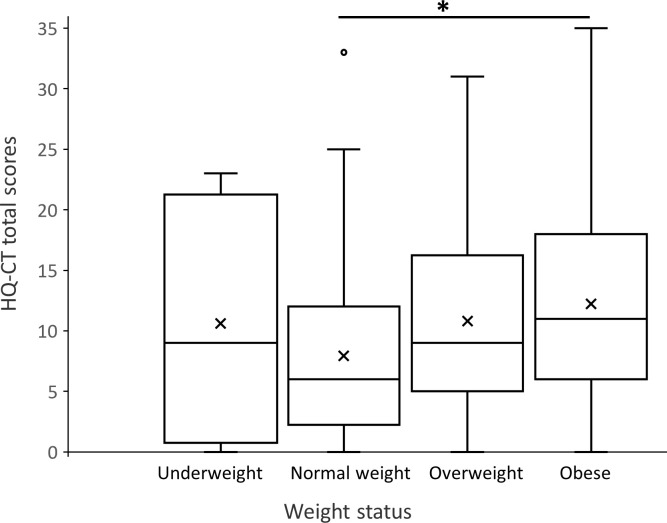
Relationship between weight status and hyperphagia.Box-and-whisker plots showed the range of HQ-CT total scores in function of individual’s weight status (*p < 0.05). Within the boxplot, the mean value is represented by the black cross, the median by the horizontal dividing line, and the top and bottom of the box represent the seventy-fifth and twenty-fifth percentile, with the whiskers indicating the maximum and minimum points and outlier points shown as small empty circles.